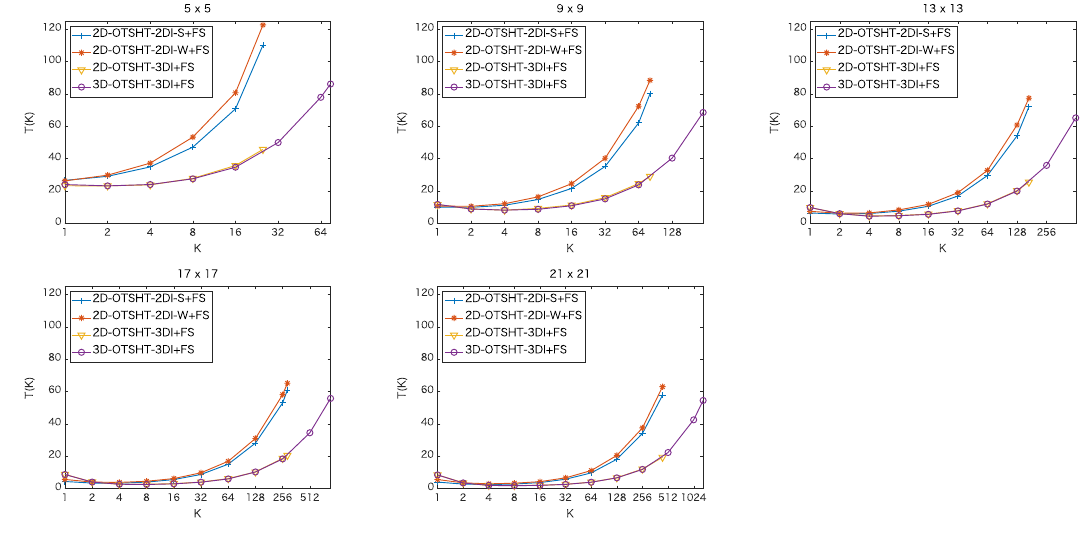
Figure 7. Mean ratio [%] of the elapsed time of each method at K basis images/blocks to the elapsed time of FS in color images of size 256 ×